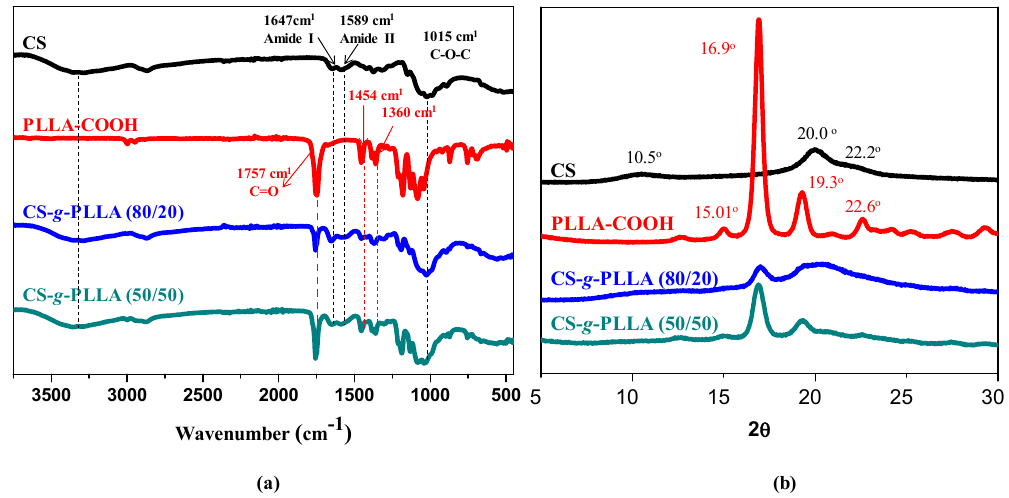
Figure 2. ( a ) Attenuated total reflectance Fourier-transform infrared (ATR-FTIR) spectra and ( b ) X-ray di ff raction (XRD) patterns of chitosan (CS) (black line), PLLA-COOH (red line), CS- g -PLLA(80 / 20) (blue line) and CS- g -PLLA(50 / 50) (green line).